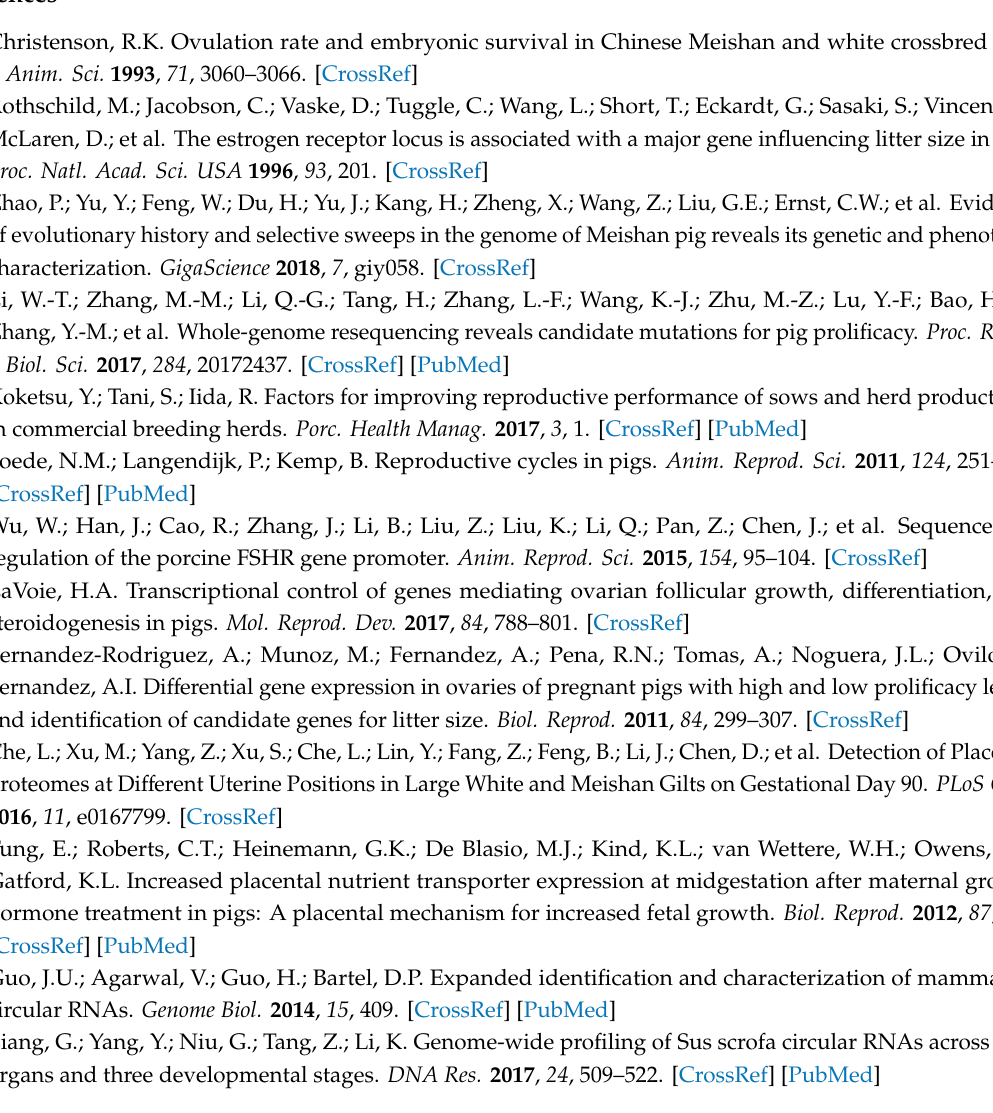
Table S1: Summary of RNA sequencing and reads mapping, Table S2: The genomic location and its parent gene for circRNAs, Table S3: Summary of the di ff erential expression analysis for circRNAs, Table S4: Summary of the di ff erential expression analysis for protein-coding